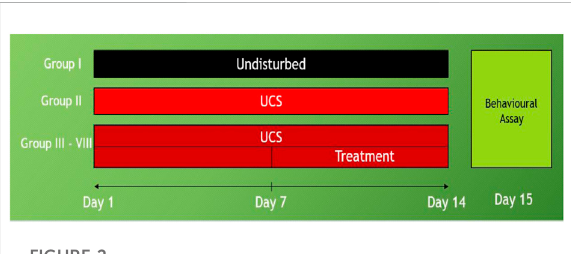
FIGURE 2 Study timeline of unpredictable chronic stress: Group I- control (non-stressed), Group II -UCS (stressed), Group III- UCS + Diazepam (US1), Group IV- UCS + Group V- Fluoxetine